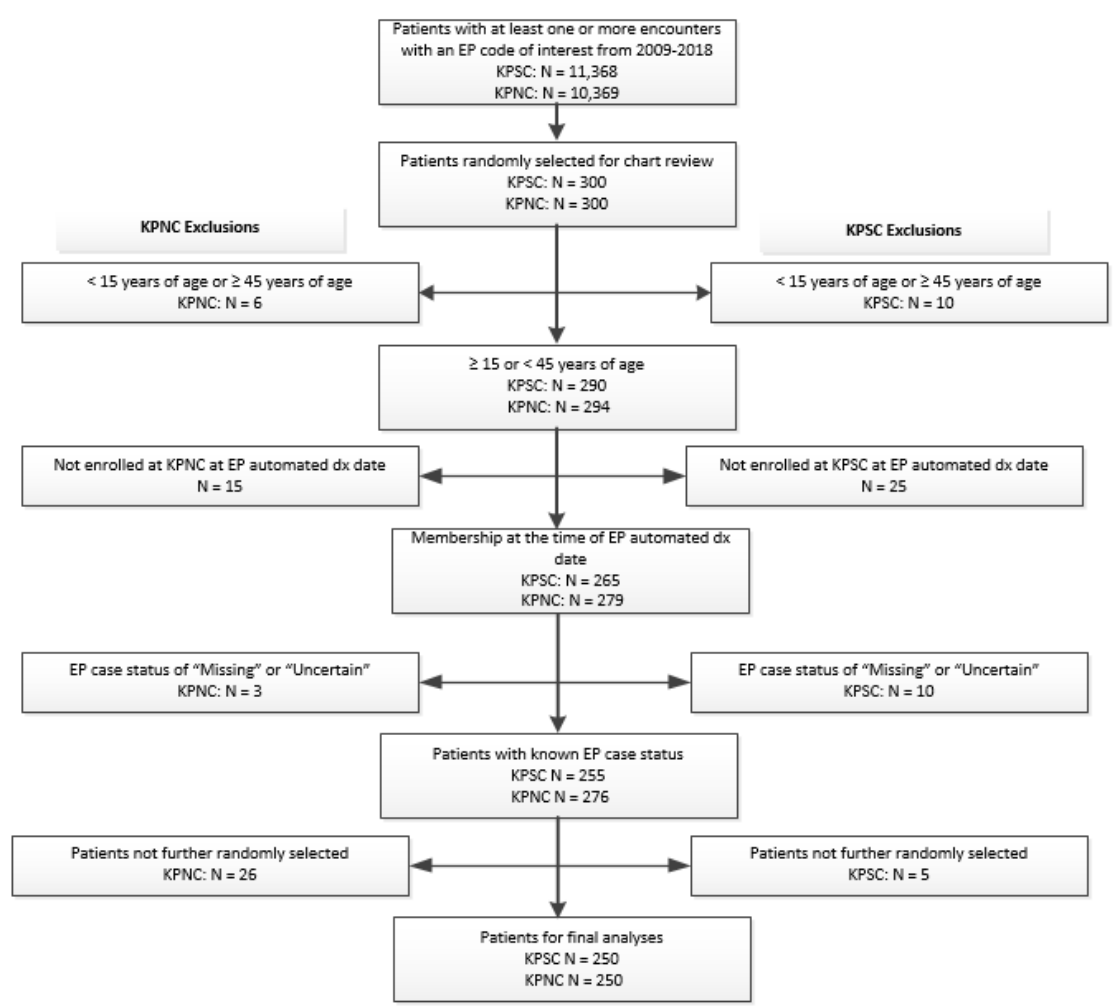
Figure 2. Flow diagram of validation study sample. EP: ectopic pregnancy. KPNC: Kaiser Permanente Northern California. KPSC: Kaiser Permanente Southern